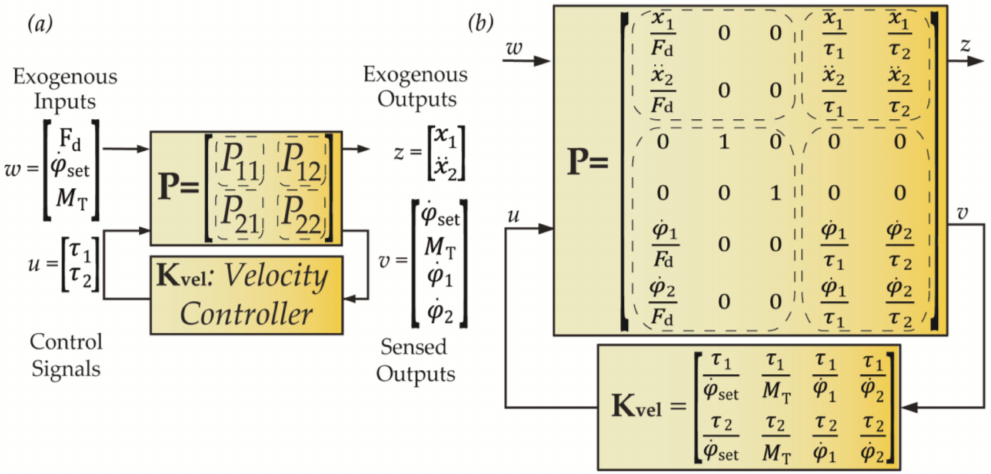
Figure 2. ( a ) Velocity controller Linear Fractional Transformation (LFT) definition, ( b ) Matrix frequency domain relationship